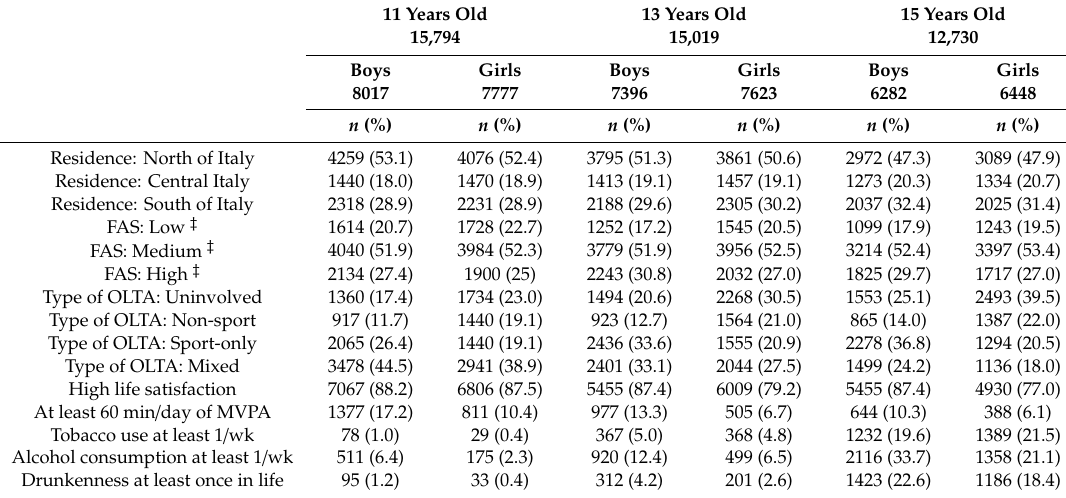
Table 1. Sociodemographic characteristics, involvement in di ff erent types of organised leisure-time activities (OLTA) and study outcomes. Health Behaviours in School-aged Children (HBSC), Italy 2014. 11 Years Old